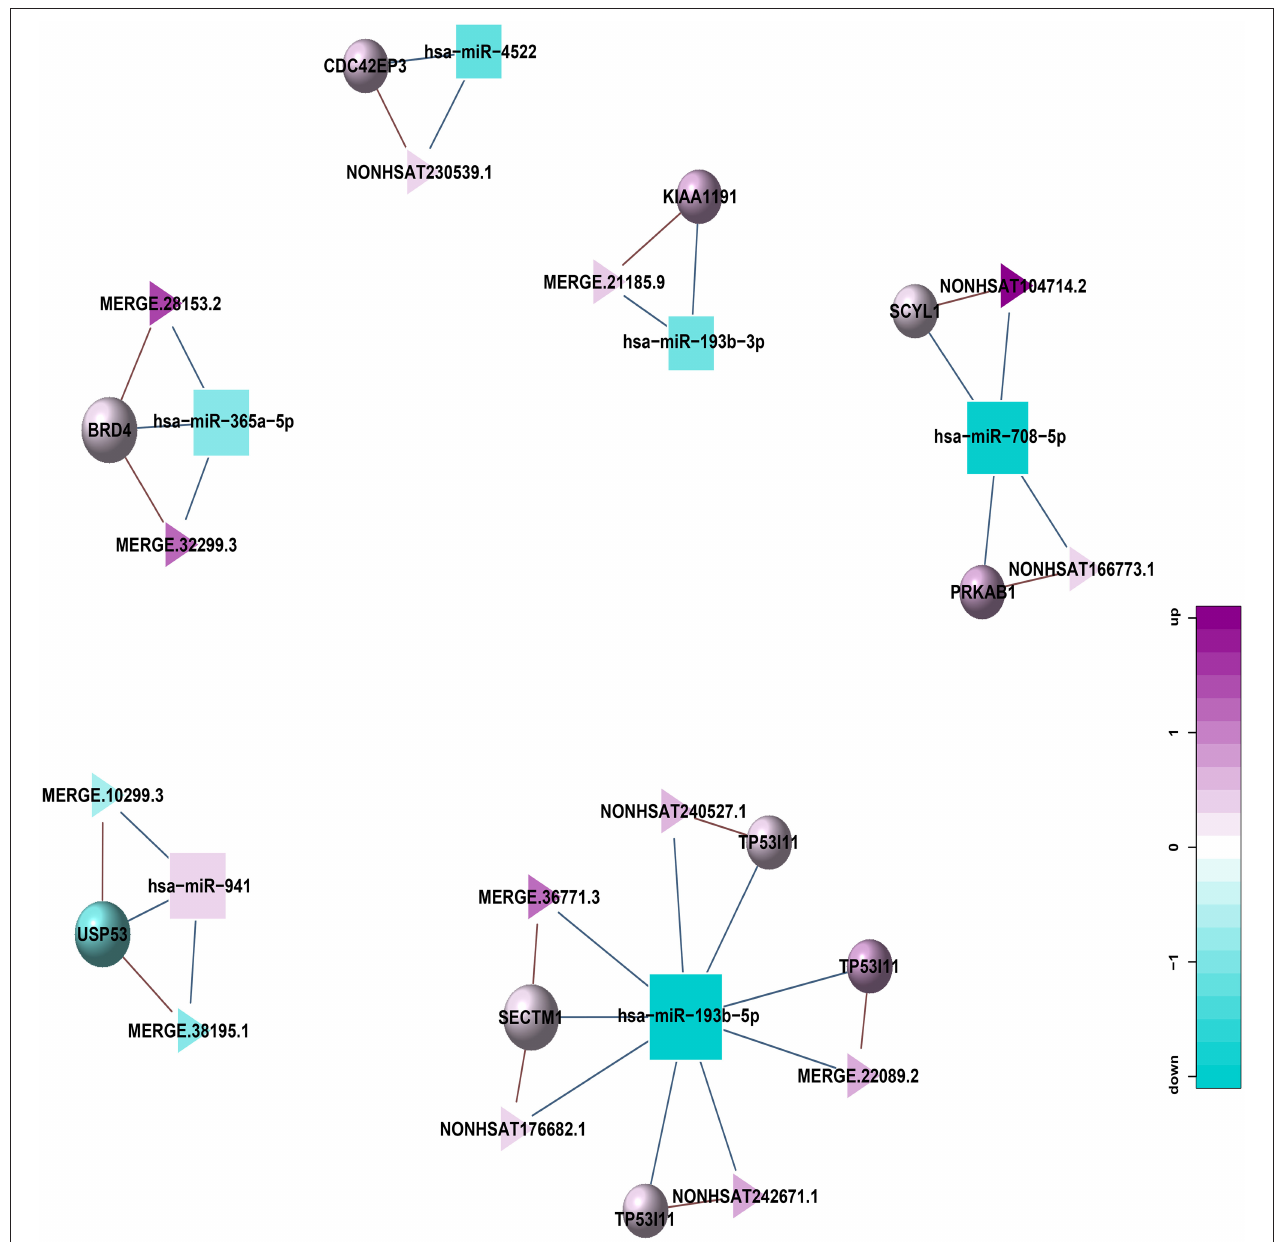
FIGURE 10 | lncRNA-miRNA-mRNA regulatory network related to HT (Triangle: lncRNA; Square: miRNA; Circle: mRNA; Blue: down-regulation; Purple: